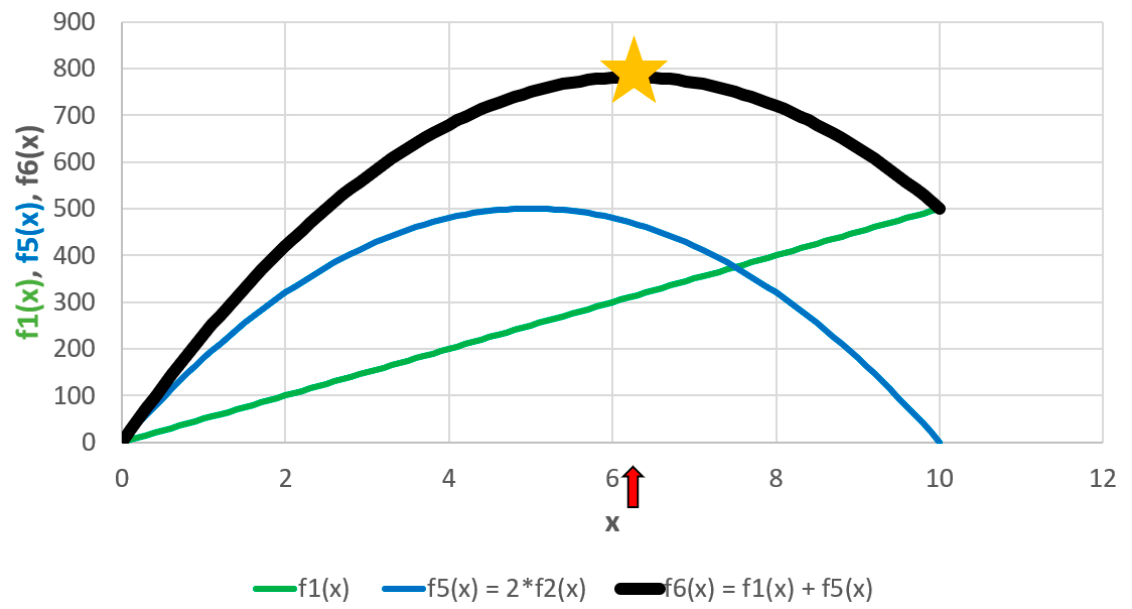
Figure 9. If the net profit of BLUE, caused by expected net losses of RED, increases by 100%, for every possible level of x, then the optimal location of the war front moves west.